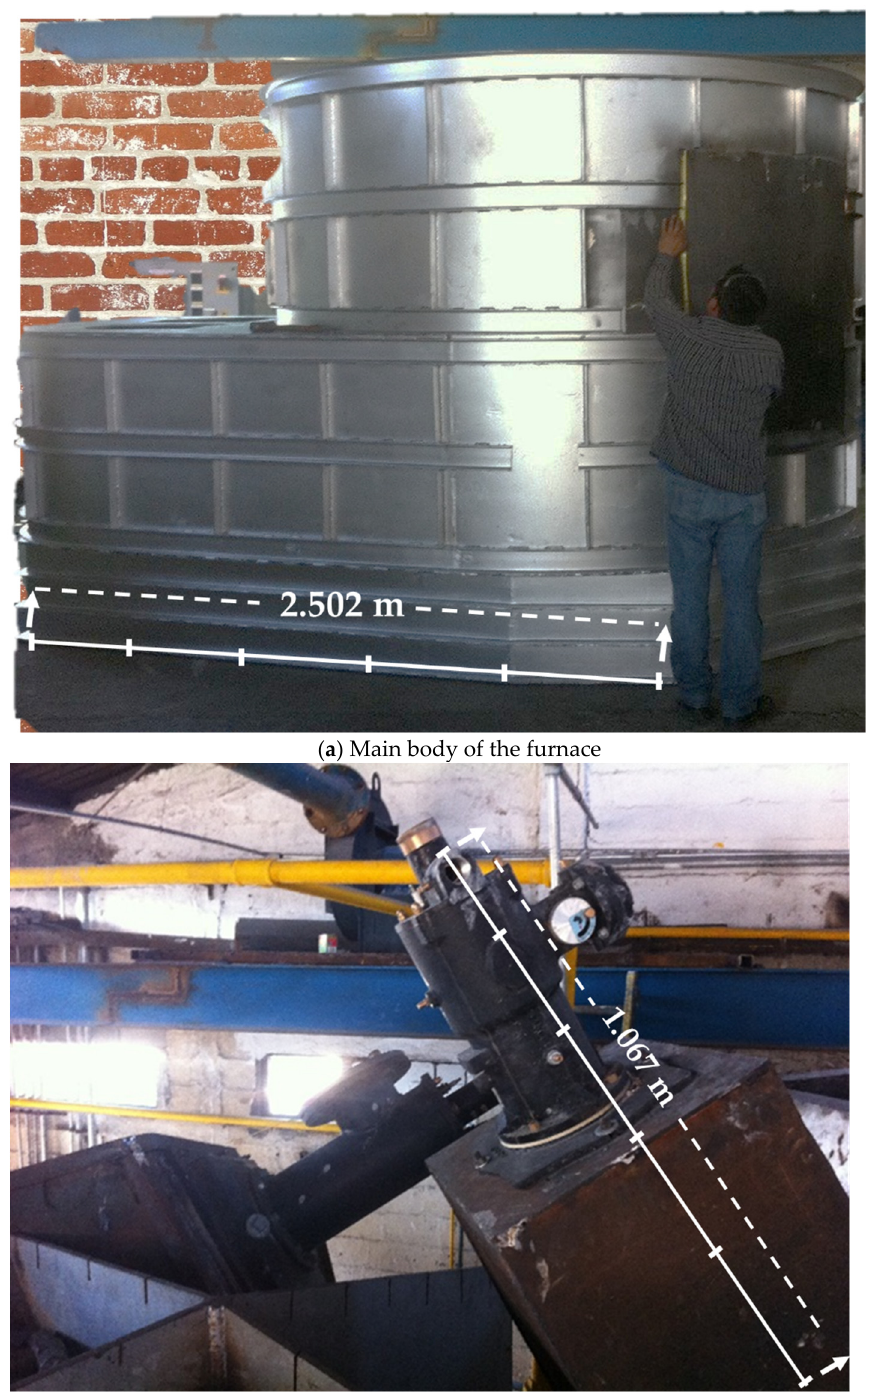
Figure 11. ( a ) Rounded-shape reverberatory furnace 5 ton molten aluminium capacity; ( b ) the high-efficiency burner po- sitioned at 45° from the horizontal. high-efficiency burner positioned at 45 ◦ from the